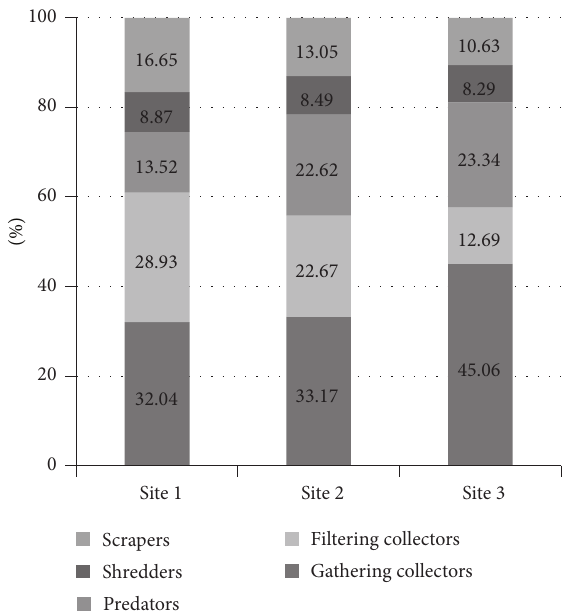
Figure 3: Feeding groups composition of the benthic macroinver- tebrate